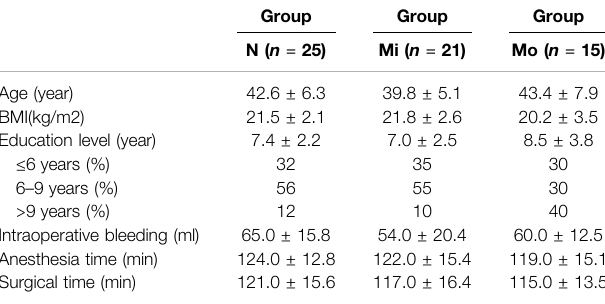
TABLE 1 | Demographic characteristics of patients of normal group, mild anemia group and moderate anemia group ( ± s). Group